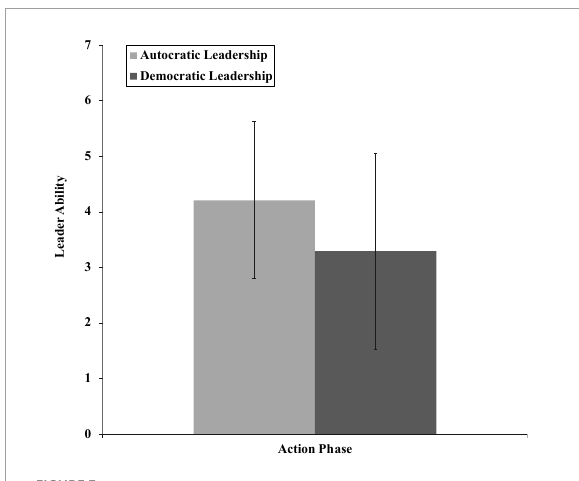
FIGURE3 The relationship between autocratic and democratic leadership and leader ability for the action phase (Study 1).